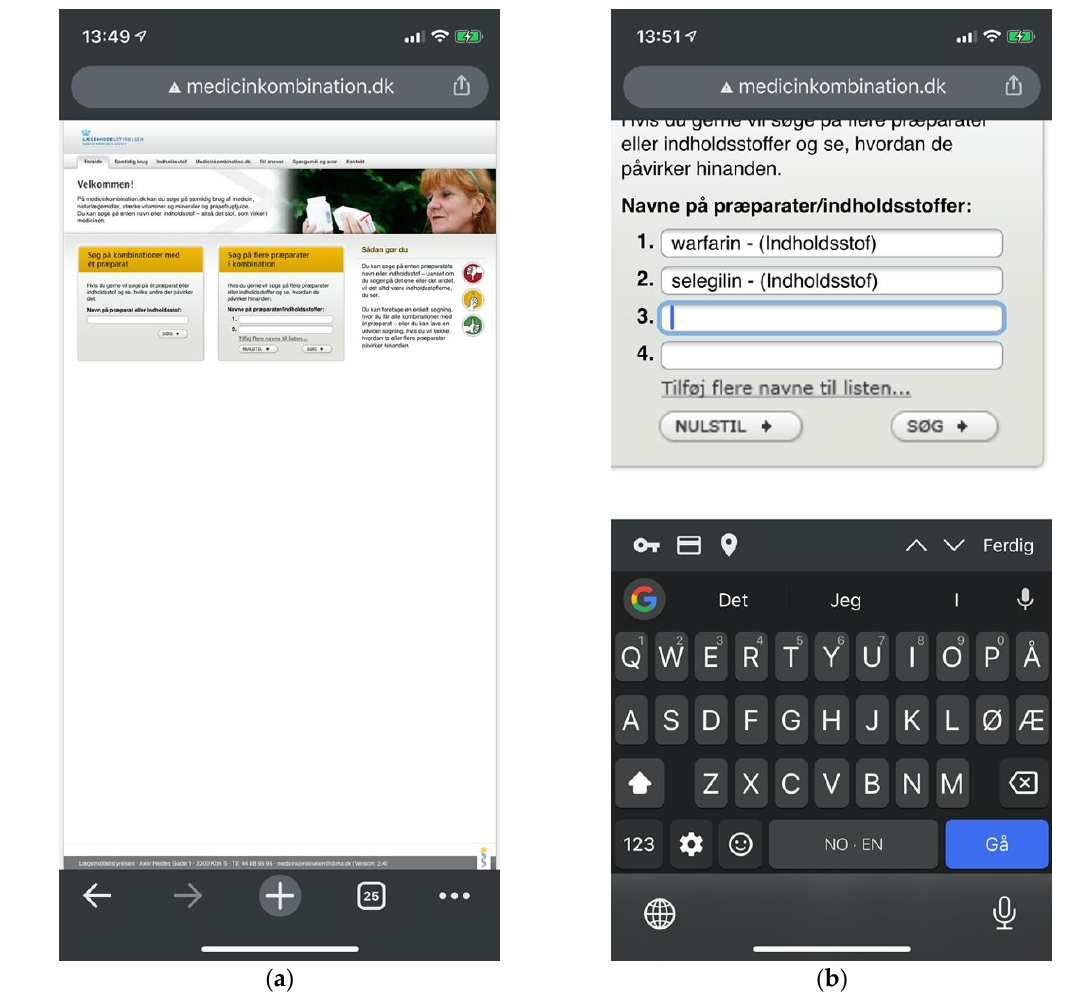
Figure 15. ( a ) Medicinkombination.dk lacking adaptive design in spite of an explicit layperson audience; ( b ) Multi-drug searches require users to manually add input fields one by one.